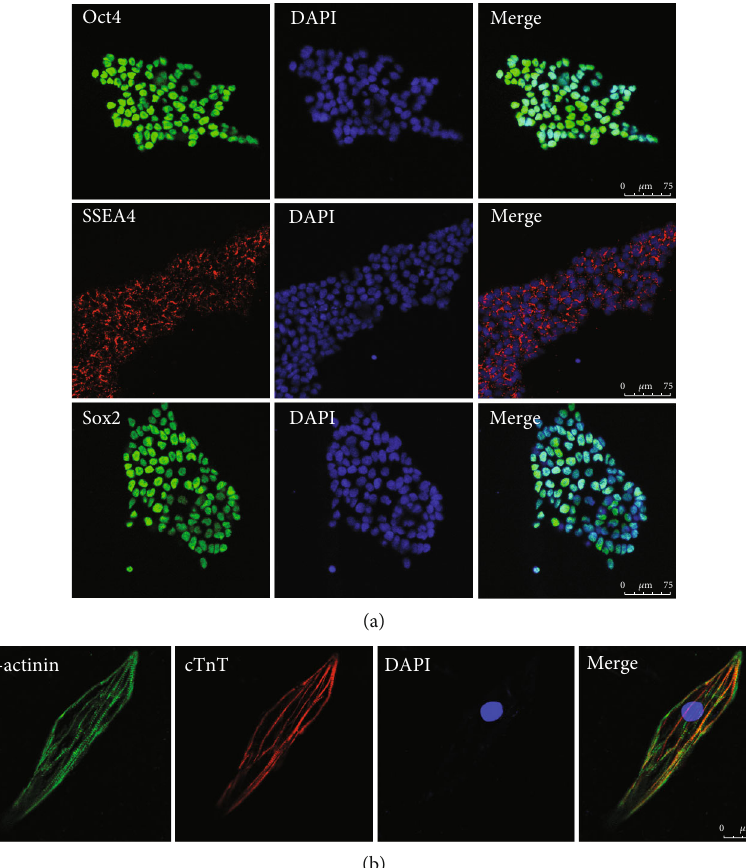
Figure 2: Characterization of hiPSCs and hiPSC-CMs. (a) Immunostaining of hiPSCs before di ff erentiation: Oct4 (green), SSEA4 (red), Sox2(green), and DAPI (blue). (b) Immunostaining of hiPSC-CMs: α -actinin (green), cTnT (red), and DAPI (blue). Oct4: octamer- binding transcription factor 4; SSEA4: stage-speci fi c embryonic antigen 4; Sox2: SRY-box transcription factor